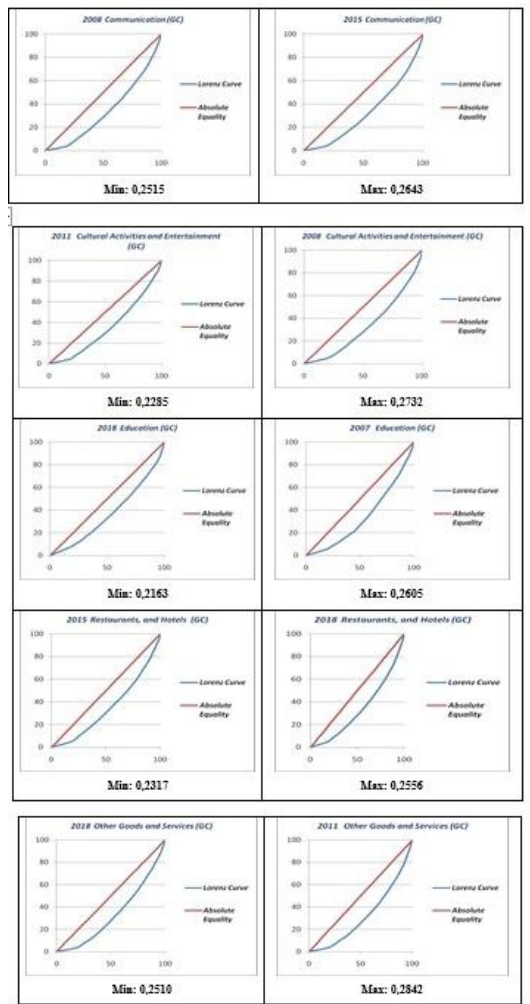
Examination of Consumption Expenditure Distribution among NUTS-2 Regions in 2007-2018 with GINI